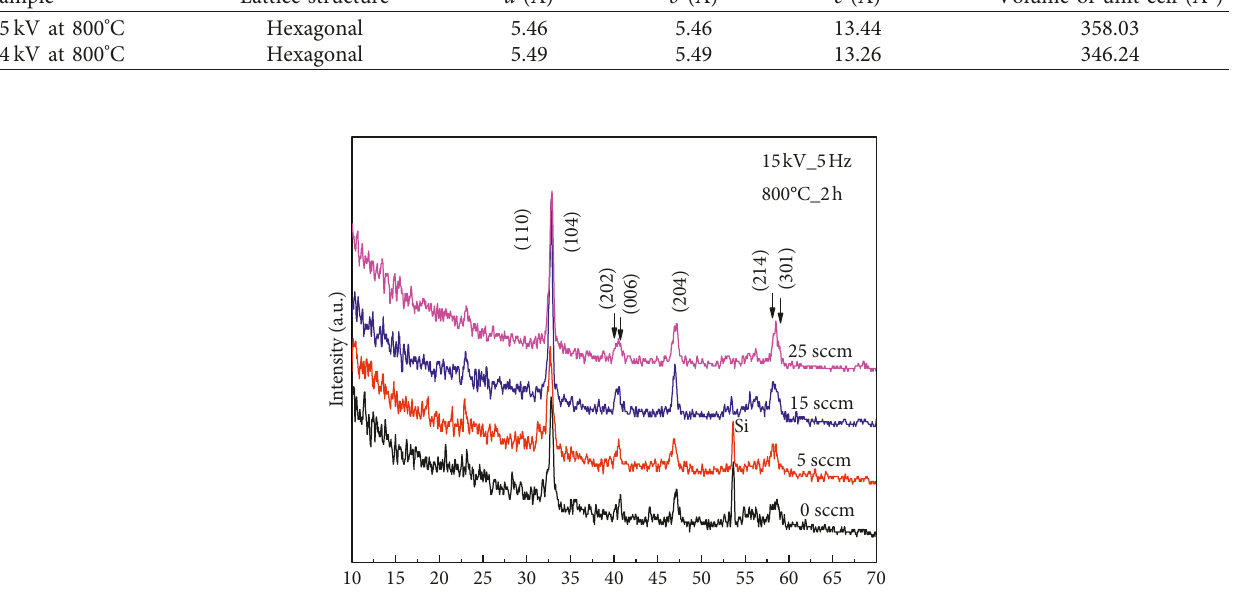
3 thin films deposited at 14 and 15 kV after annealing at 800